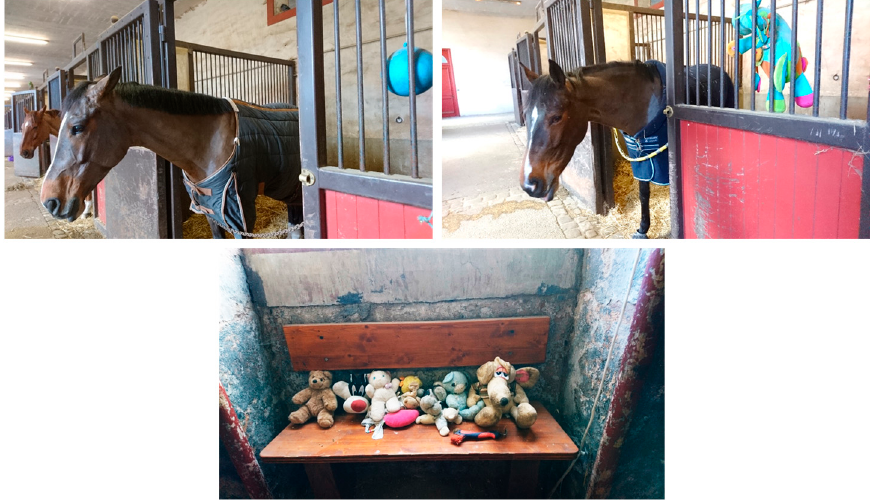
Figure 2. Examples of environmental enrichments placed in the stall and as a stock for turnover. © Photo credit: Martine Hausberger.